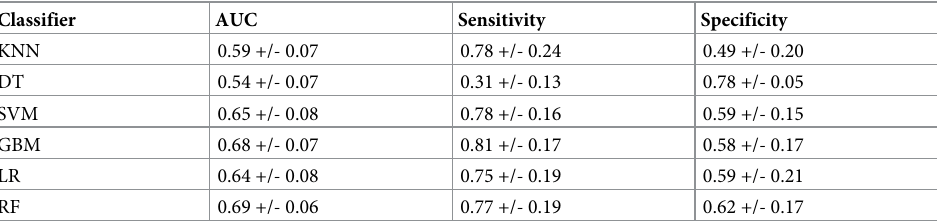
Table 3. Performance of ML